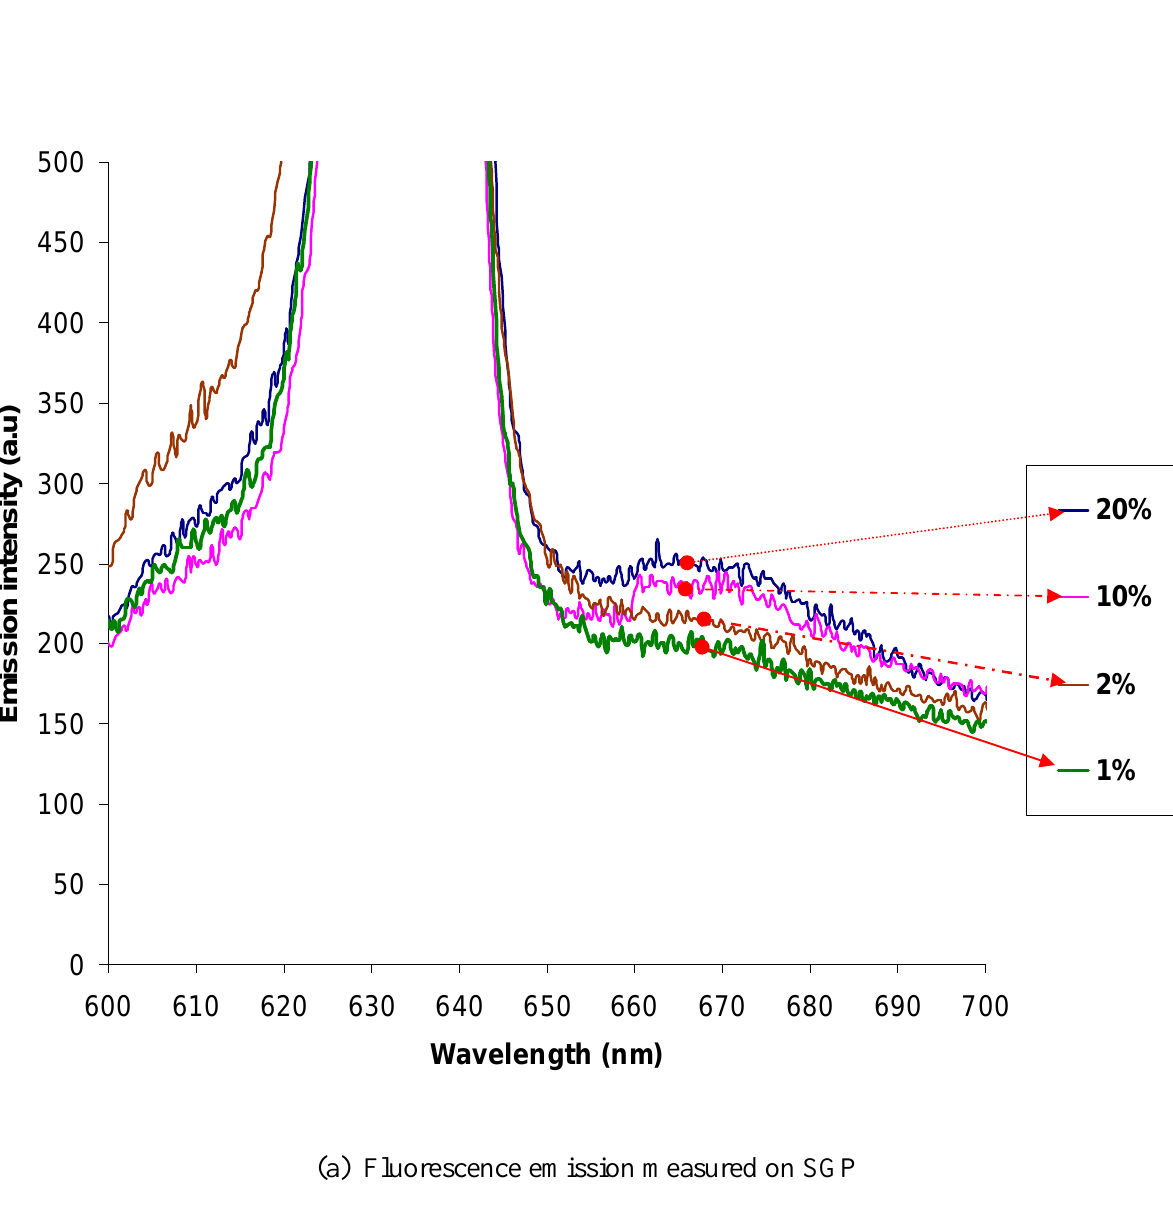
Figure 9: Fluorescence spectral response curve of Alexafluor 647-antibody with sheep IgG on (a) SGP chip (b) SiPy